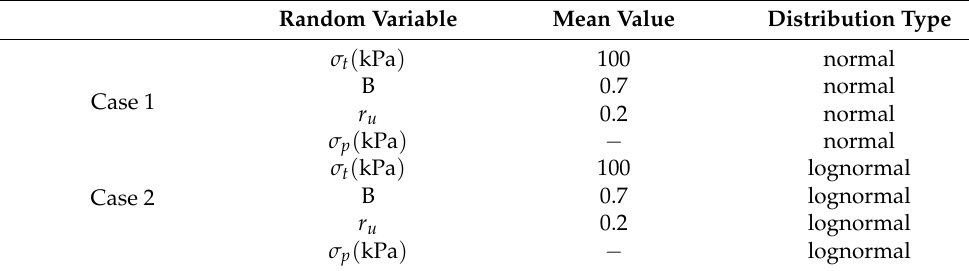
Table 1. Statistical values of random variables used in analysis with COV =